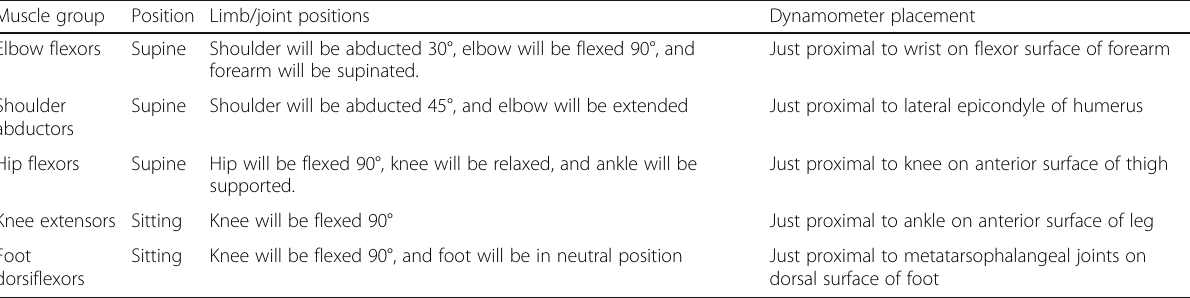
Table 1 Muscle groups test for limb/joint positions and dynamometer placement Muscle